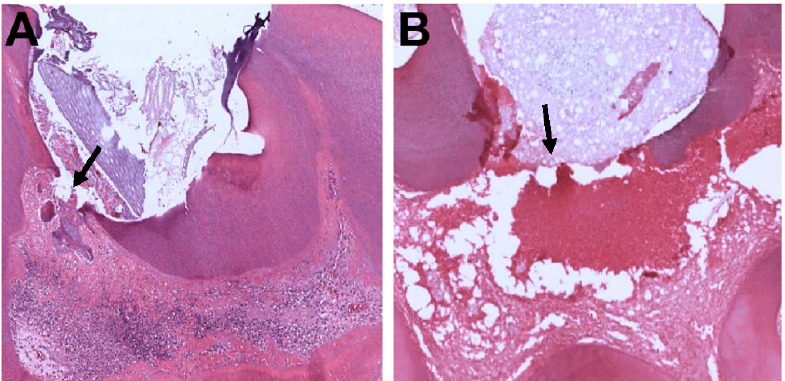
Figure 1. Histologic features of maxillary first molars subjected to pulp exposure and restored with glass ionomer without the use of pulp capping agent at week one. Representative photomicrographs showing ( A ) diffuse inflammation and ( B ) degenerated pulp with granulation tissue filling the exposure area. H&E stain ×200 magnification. Arrows indicate the exposure area.